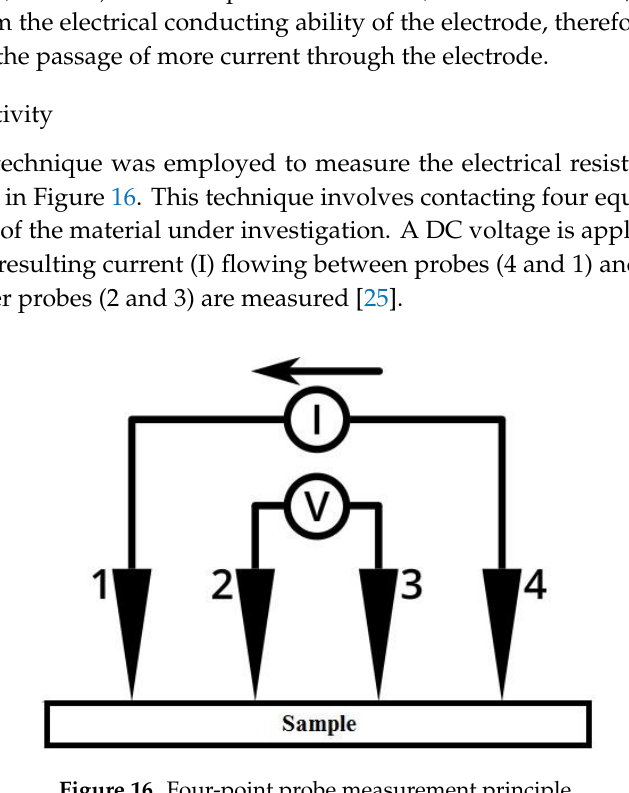
Figure 16. Four-point probe measurement